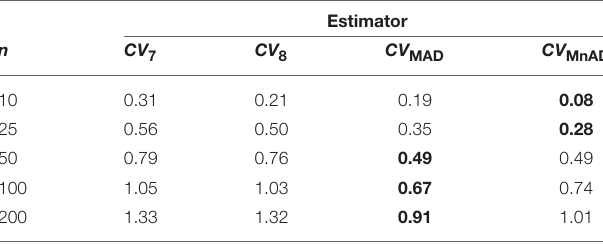
TABLE 7 | Median values of log 10 ( γ ) accuracy metric across θ produced for each estimator and sample sizes under Beta distribution. Estimator